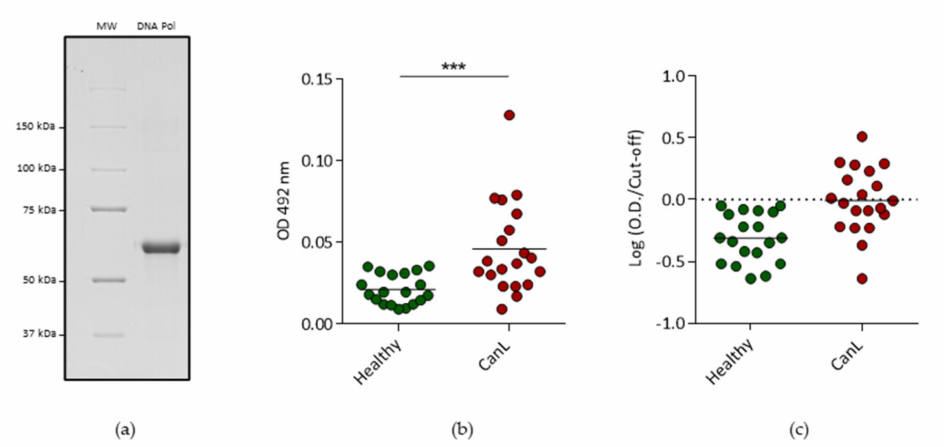
Figure 9. ( a ) SDS-PAGE analysis of the recombinant putative DNA Polymerase epsilon subunit b after expression at 37 ◦ C, inclusion bodies isolation and solubilization and protein extraction. The band represented in the SDS-PAGE corresponds to 2.5 µ g of the recombinant protein. MW—molecular weight; DNA Pol—putative DNA Polymerase epsilon subunit b; ( b ) Reactivity of sera from healthy and CanL dogs to putative DNA Polymerase epsilon subunit b determined by ELISA. Coating was done with 5 µ g/mL of recombinant protein. Results are represented as the optical density at 492 nm. Data was generated from the average of two independent assays. Statistical significance was determined using the Mann–Whitney test. ***— p < 0.001 ( c ) Reactivity of sera from healthy and CanL dogs to putative DNA Polymerase epsilon subunit b determined by ELISA. Results are represented as the logarithm of the optical density (OD) at 492 nm normalized by the populational cut-off value (mean of the OD of the healthy samples + 2 standard deviations) for each antigen. The dashed line represents the cut-off. Data was generated from the average of two independent